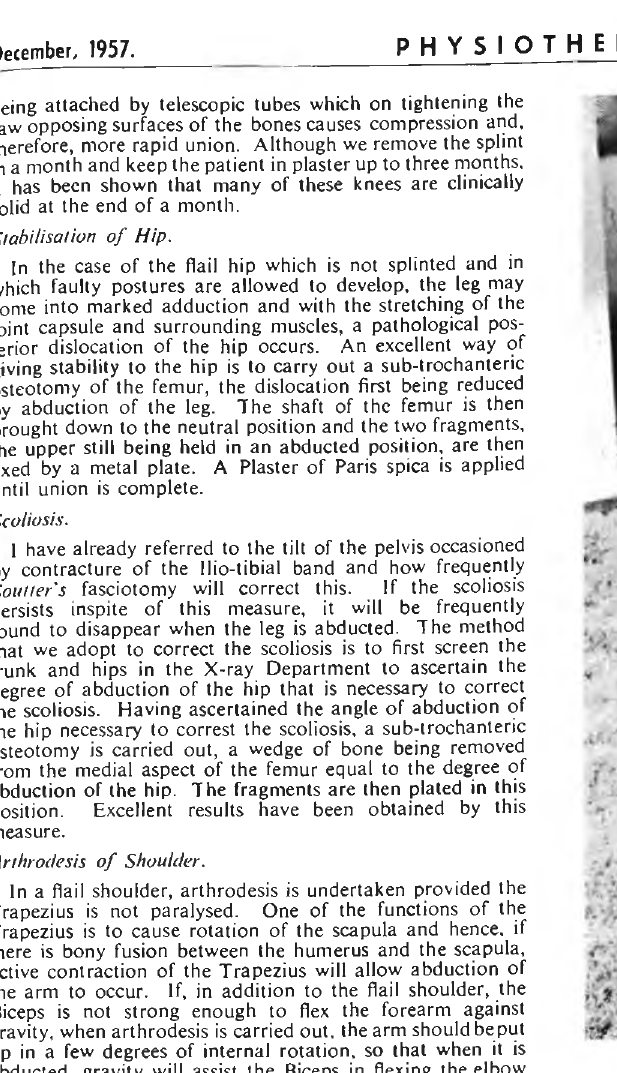
Wilson Bingiwe— After